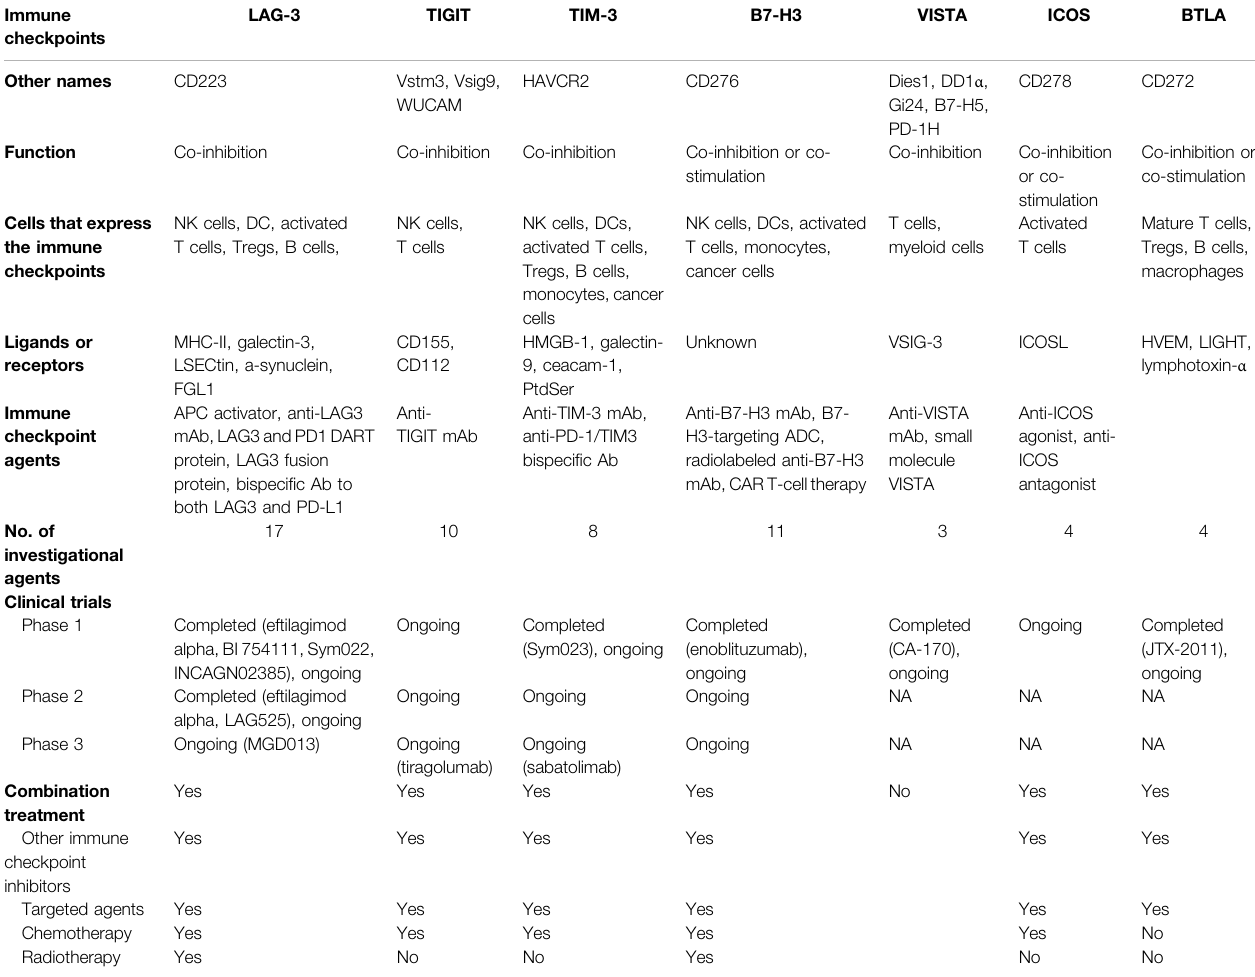
TABLE 1 | Overview of novel immune checkpoints. Immune